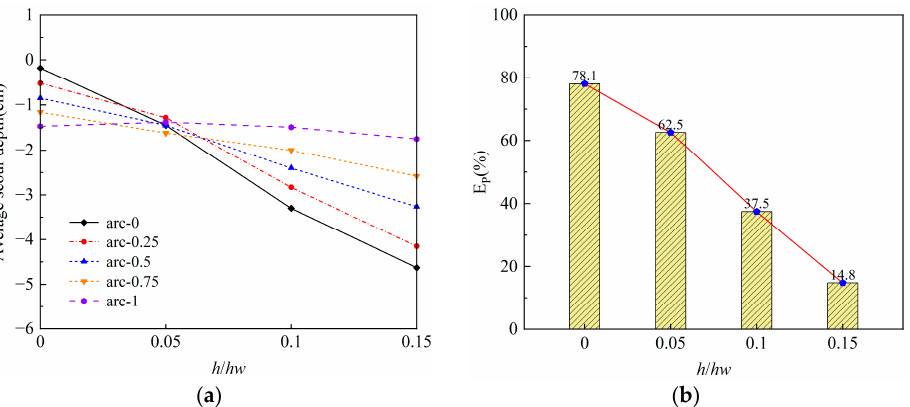
Figure 13. ( a ) Variation of average scour depth and installation height. ( b ) Variation of reduction efficiency of the collar and installation height.